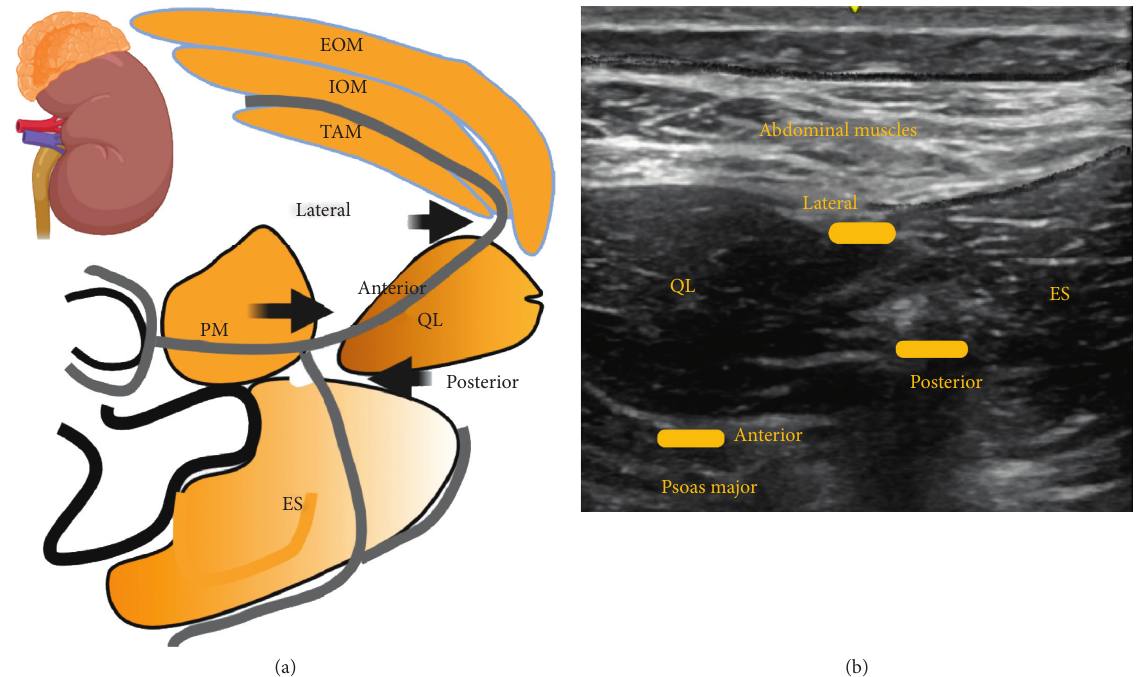
Figure 5: EOM: external oblique muscle; IOM: internal oblique muscle; TAM: transversus abdominis muscle; PM: psoas major; QL: quadratus lumborum, ES: erector spinae muscle. Black arrows indicate the point of local anaesthetic infiltration. Anterior, lateral, and posterior indicate the types of QL blocks and point of local anaesthetic infiltration. The grey lines represent thoracolumbar